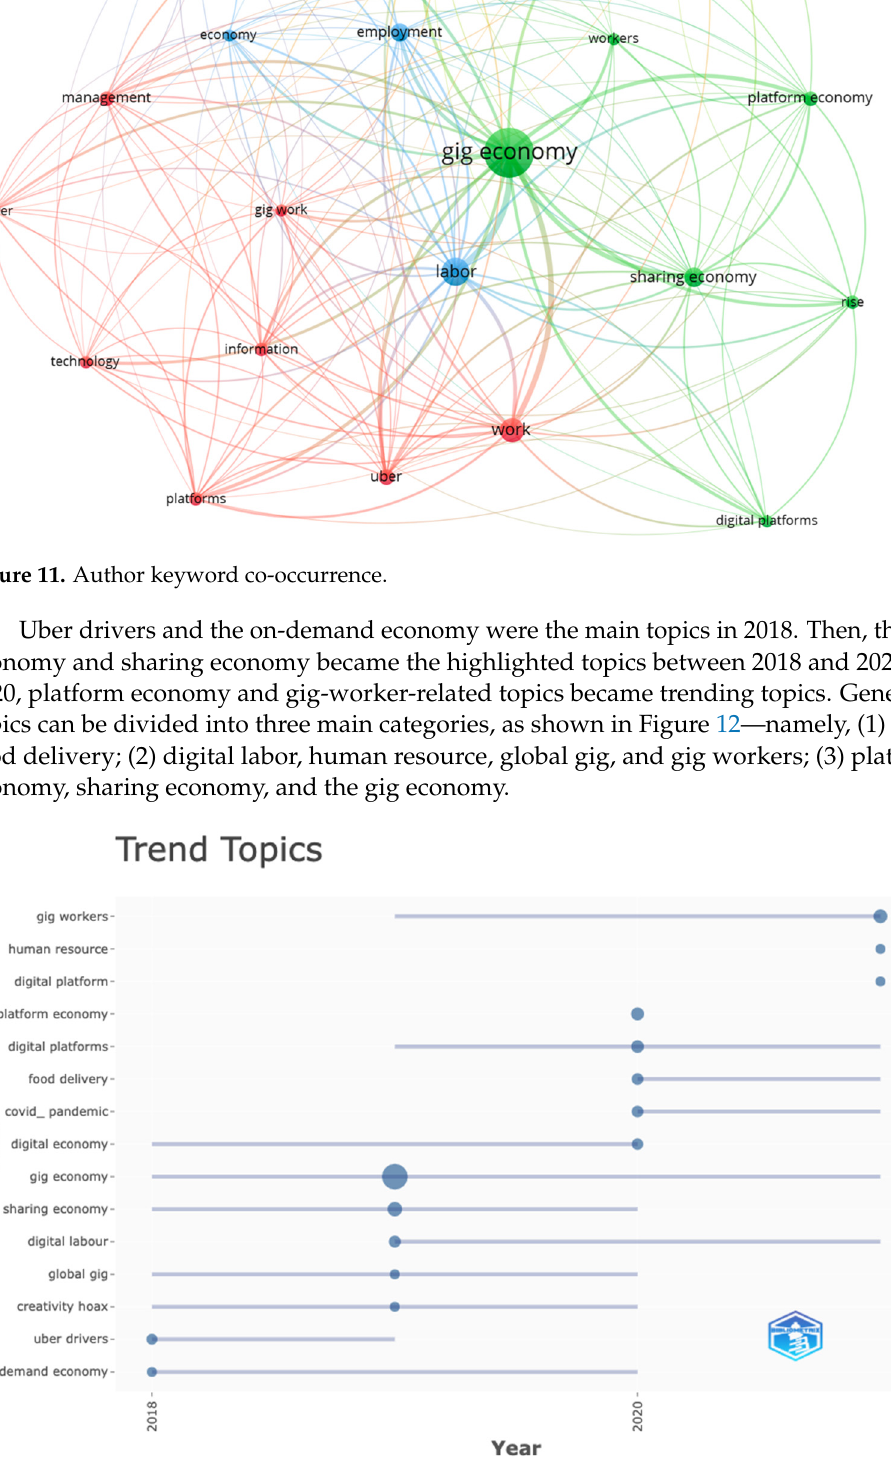
Figure 12. Trending